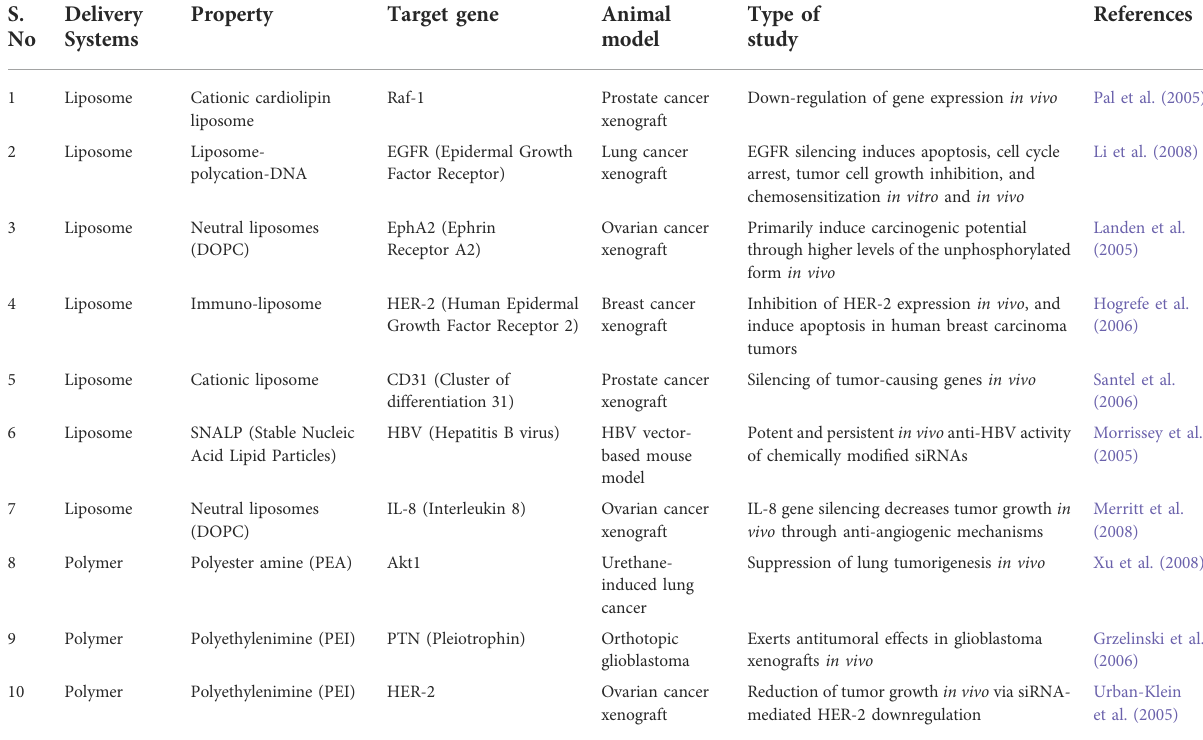
TABLE 1 Examples of siRNA delivery systems in the treatment of cancers. S.